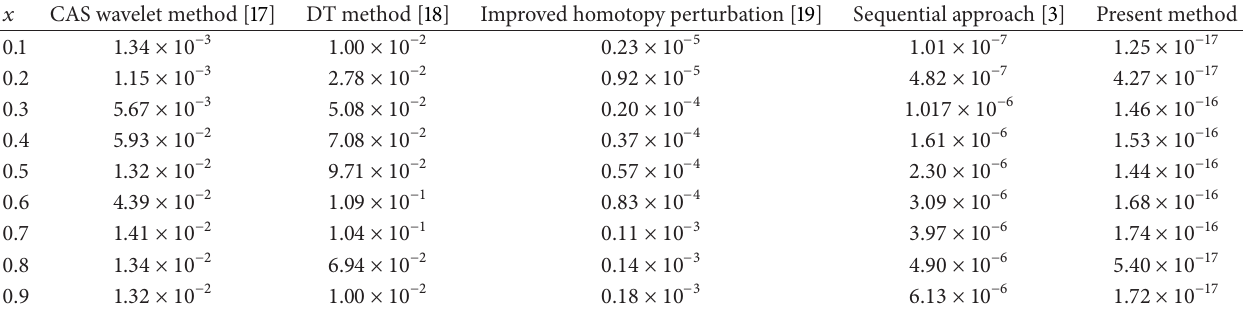
Table 7: A comparison of absolute errors between DTM, IHPM, Sa, and present method.